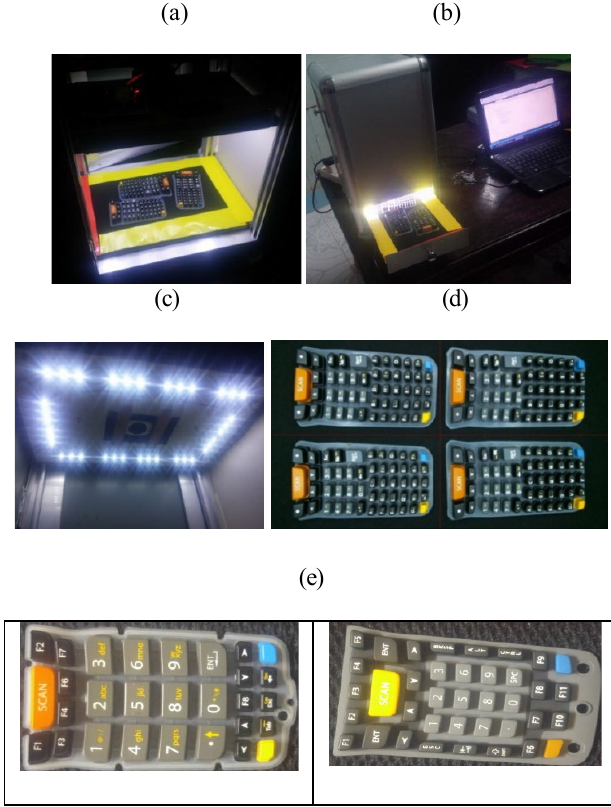
Figure 1. Defects in keypad